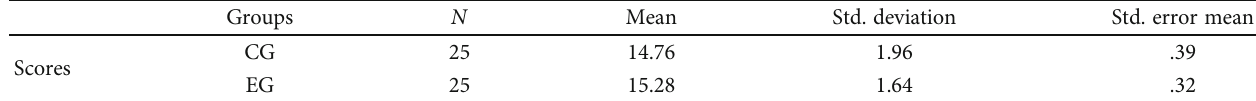
Table 1: Descriptive statistics of the grammar pretests.